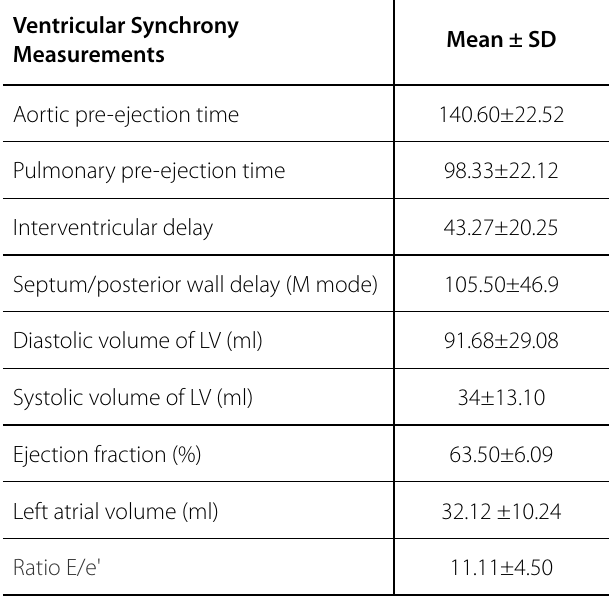
Table 1. Clinical and pacing echocardiographic characteristics